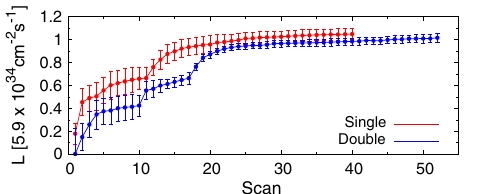
FIG. 5. Tuning convergence for single (red) and double (blue) beam studies. Each dot is the mean value of 100 machines, while the error bar is the standard deviation at each